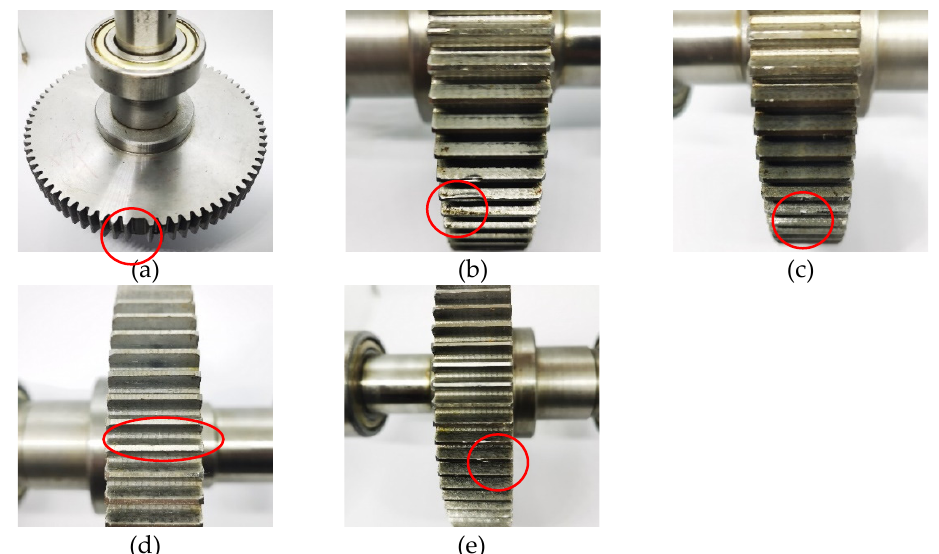
Figure 8. Gear fault diagram. ( a ) Broken gear teeth ( b ) Local wear ( c ) Pitting ( d ) Tooth profile ( e ) Tooth root fracture.